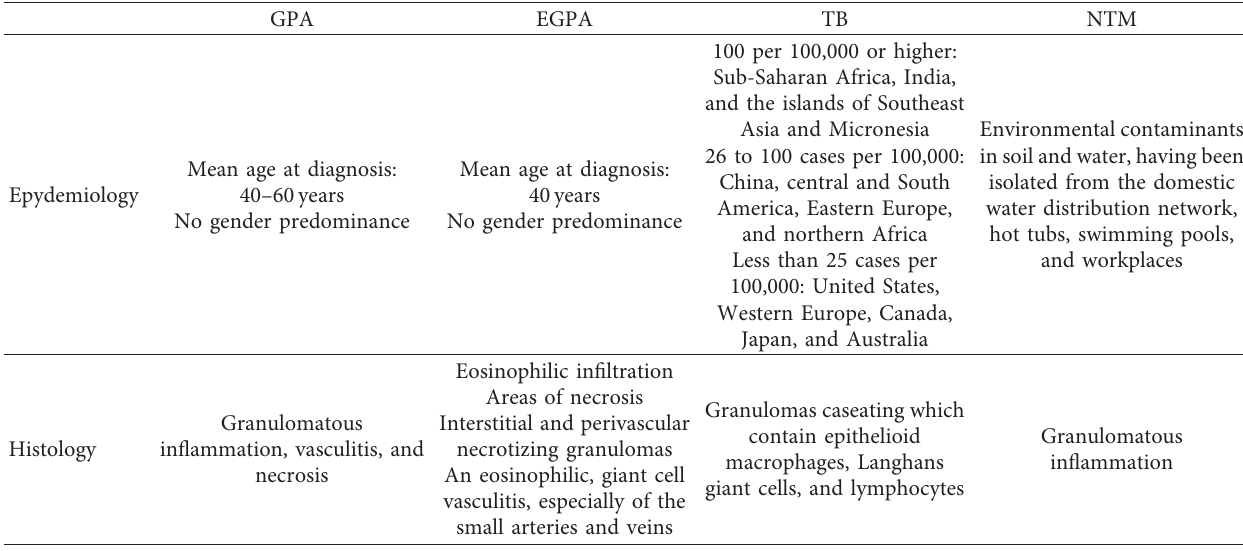
Table 3: Main differential diagnosis of NGS and their typical characteristics. GPA: granulomatosis with polyangiitis; FSGS: focal segmental glomerulosclerosis; EGPA: eosinophilic granulomatosis with polyangiitis; TB: tuberculosis; NTM: nontuberculous mycobacteria; BAL: bronchoalveolar lavage; ANCA: antineutrophil cytoplasmic antibodies; CRP: C-reactive protein; SIADH: syndrome of inappropriate antidiuretic hormone secretion; TC: computed tomography; and AFB: acid-fast